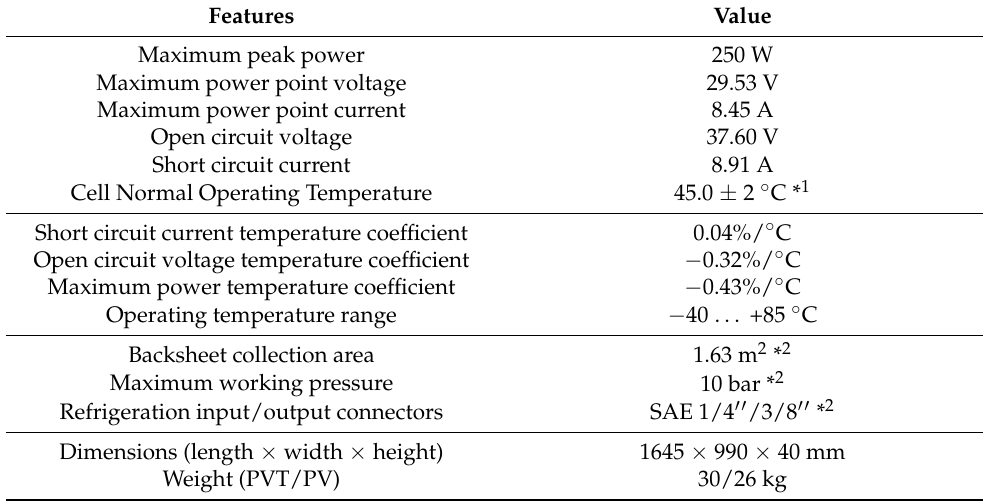
Table 2. PVT collector and PV module main features.